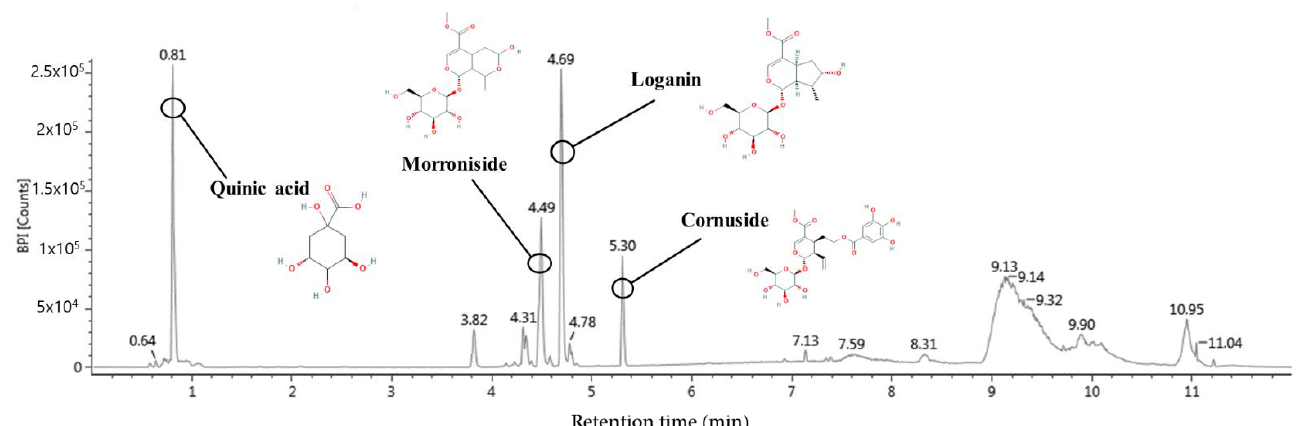
Figure 10. UPLC-Q-TOF/MS chromatogram of the ethyl acetate fraction from Corni fructus (WCF). Table 3. Identification of main compounds in the ethyl acetate fractions from Corni fructus (WCF) by UPLC-Q-TOF/MS 2 system. Compound Retention time (min) Quinic acid